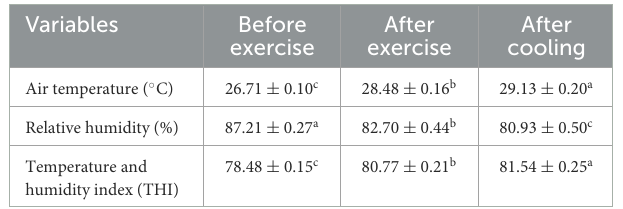
FrontiersinVeterinaryScience